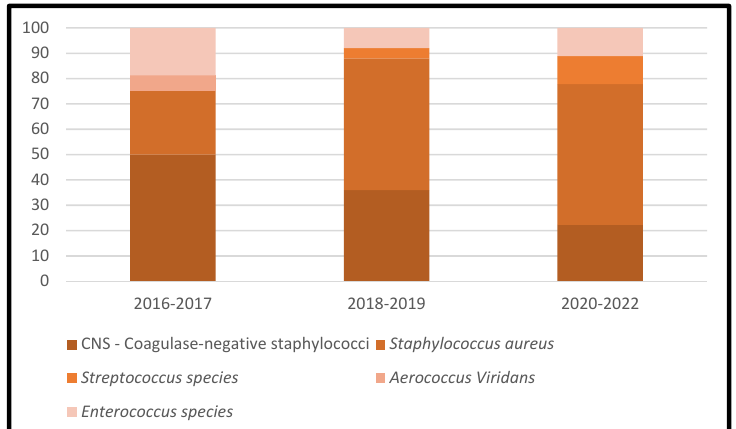
Figure 3. Trends in the microbial etiology of PJIs: distribution of gram-positive aerobic or micro- aerophilic cocci.